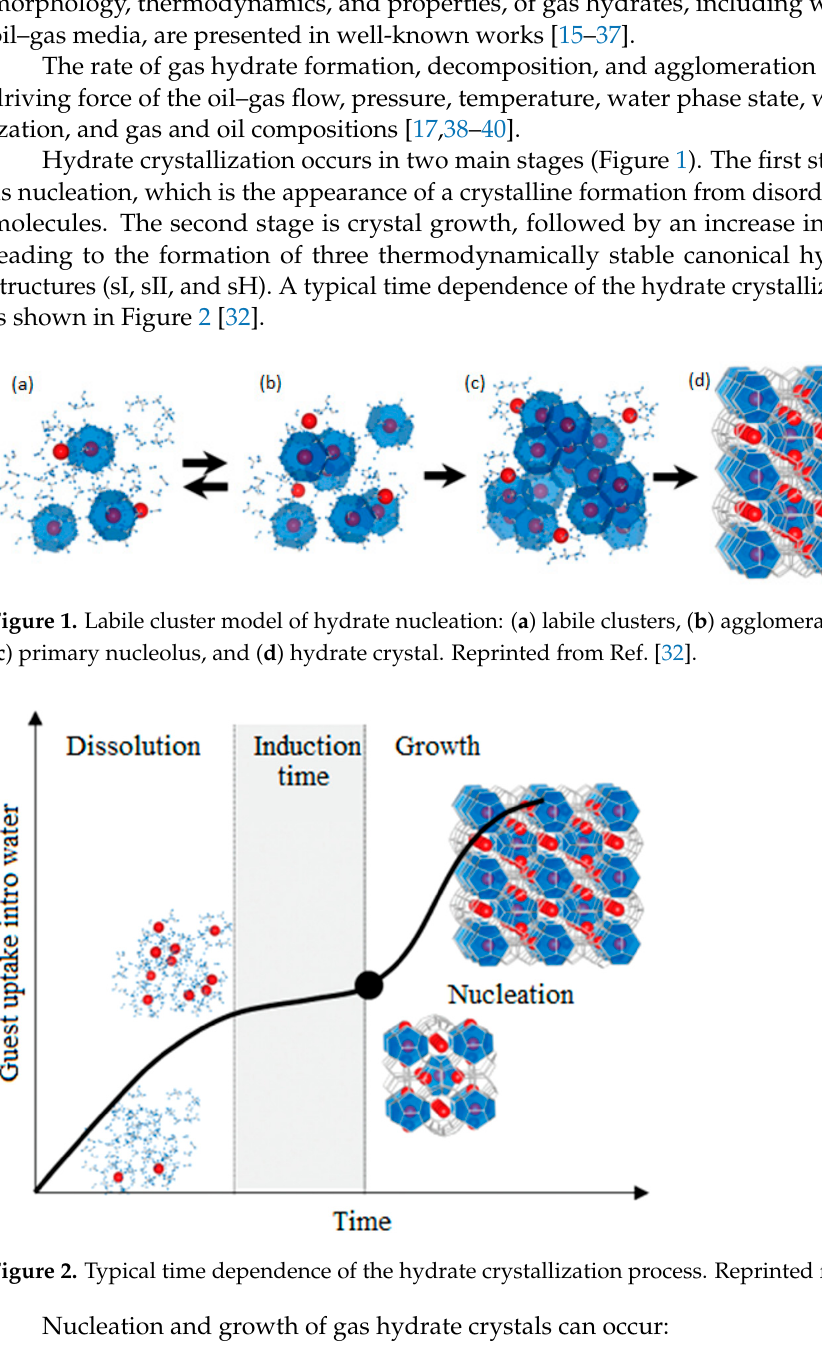
Figure 3. Schematic model of a multiphase flow in a pipeline, where hydrate crystal aggregates can flow in gaseous, oleic, and aqueous phases and/or deposit onto the pipe solid surface; ( b ) schematic diagram of the drivers of hydrate crystal formation and aggregation in hydrocarbon transportation pipelines and three-step process of ( i ) hydrate nucleation, ( ii ) crystal growth, and ( iii ) blockage. The transverse ( a ) and longitudinal ( b ) cross-section of the pipeline. Reproduced from Ref [32]. Dissociation of gas hydrates can occur in multiphase systems during the flow of hydrates in a water–oil–gas dispersed medium, because hydrate decomposition is influenced by the collision effect, including its own kinetic velocity, the effect of mass and heat transfer, and the nature of the multiphase flow of the oil and gas fluid. The kinetics of hydrate dissociation with respect to heat and mass transfer inside pipelines is